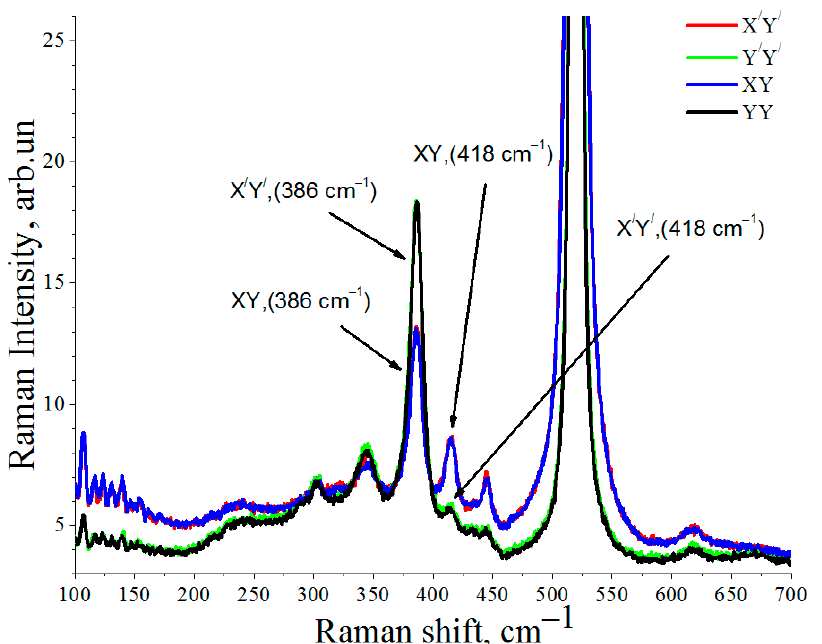
Figure 4. Polarized Raman scattering spectra with different polarizations of incident and scattered light for the L2 region.